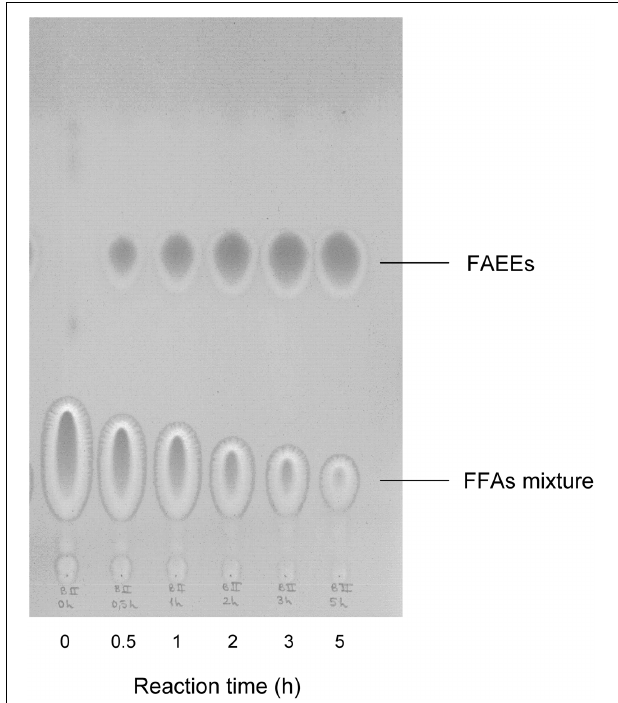
FIGURE 6 | Analysis by TLC of biodiesel (FAEEs) conversion from a FFA mixture using mCLEA-CALB. The reaction mixture containing 500 μ mol FFA (4.1% stearic acid, 23.6% palmitic acid, 52.1% oleic acid, 12.4% linoleic acid, and 7.8% linolenic acid), ethanol (10:1 alcohol:FFA molar ratio) and 2mg mCLEA-CALB was incubated for 5h at 30 ◦ C with rotational mixing.